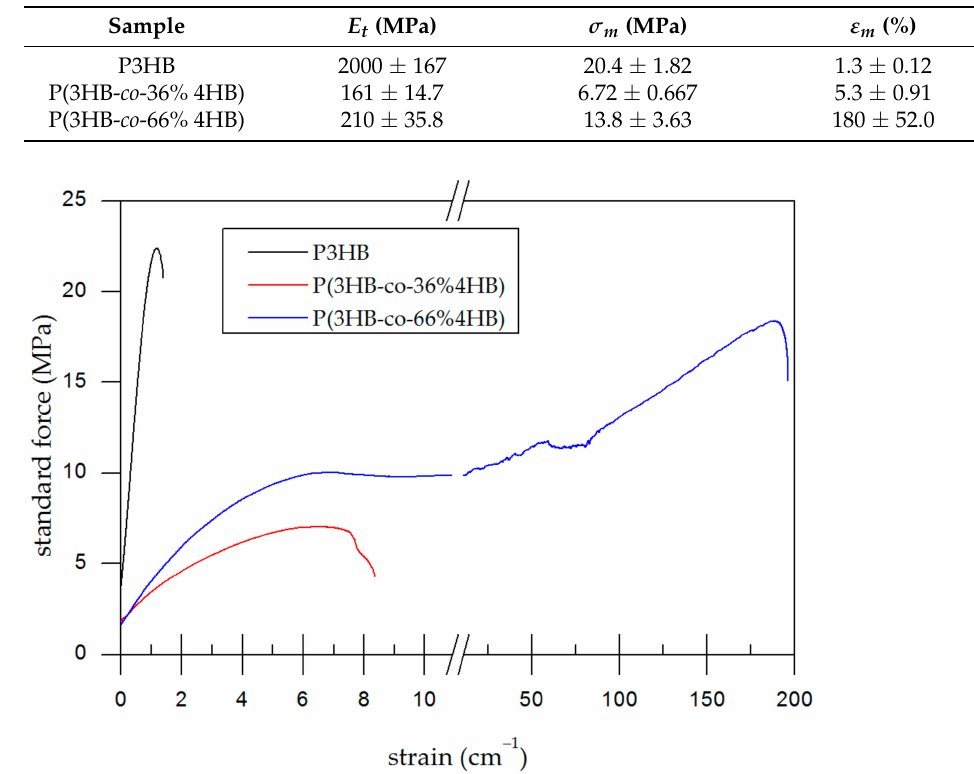
Figure 4. Typical stress − strain curves demonstrating differences in ducilities of the tested homopoly- mer (P3HB) and the P(3HB- co -4HB) copolymers